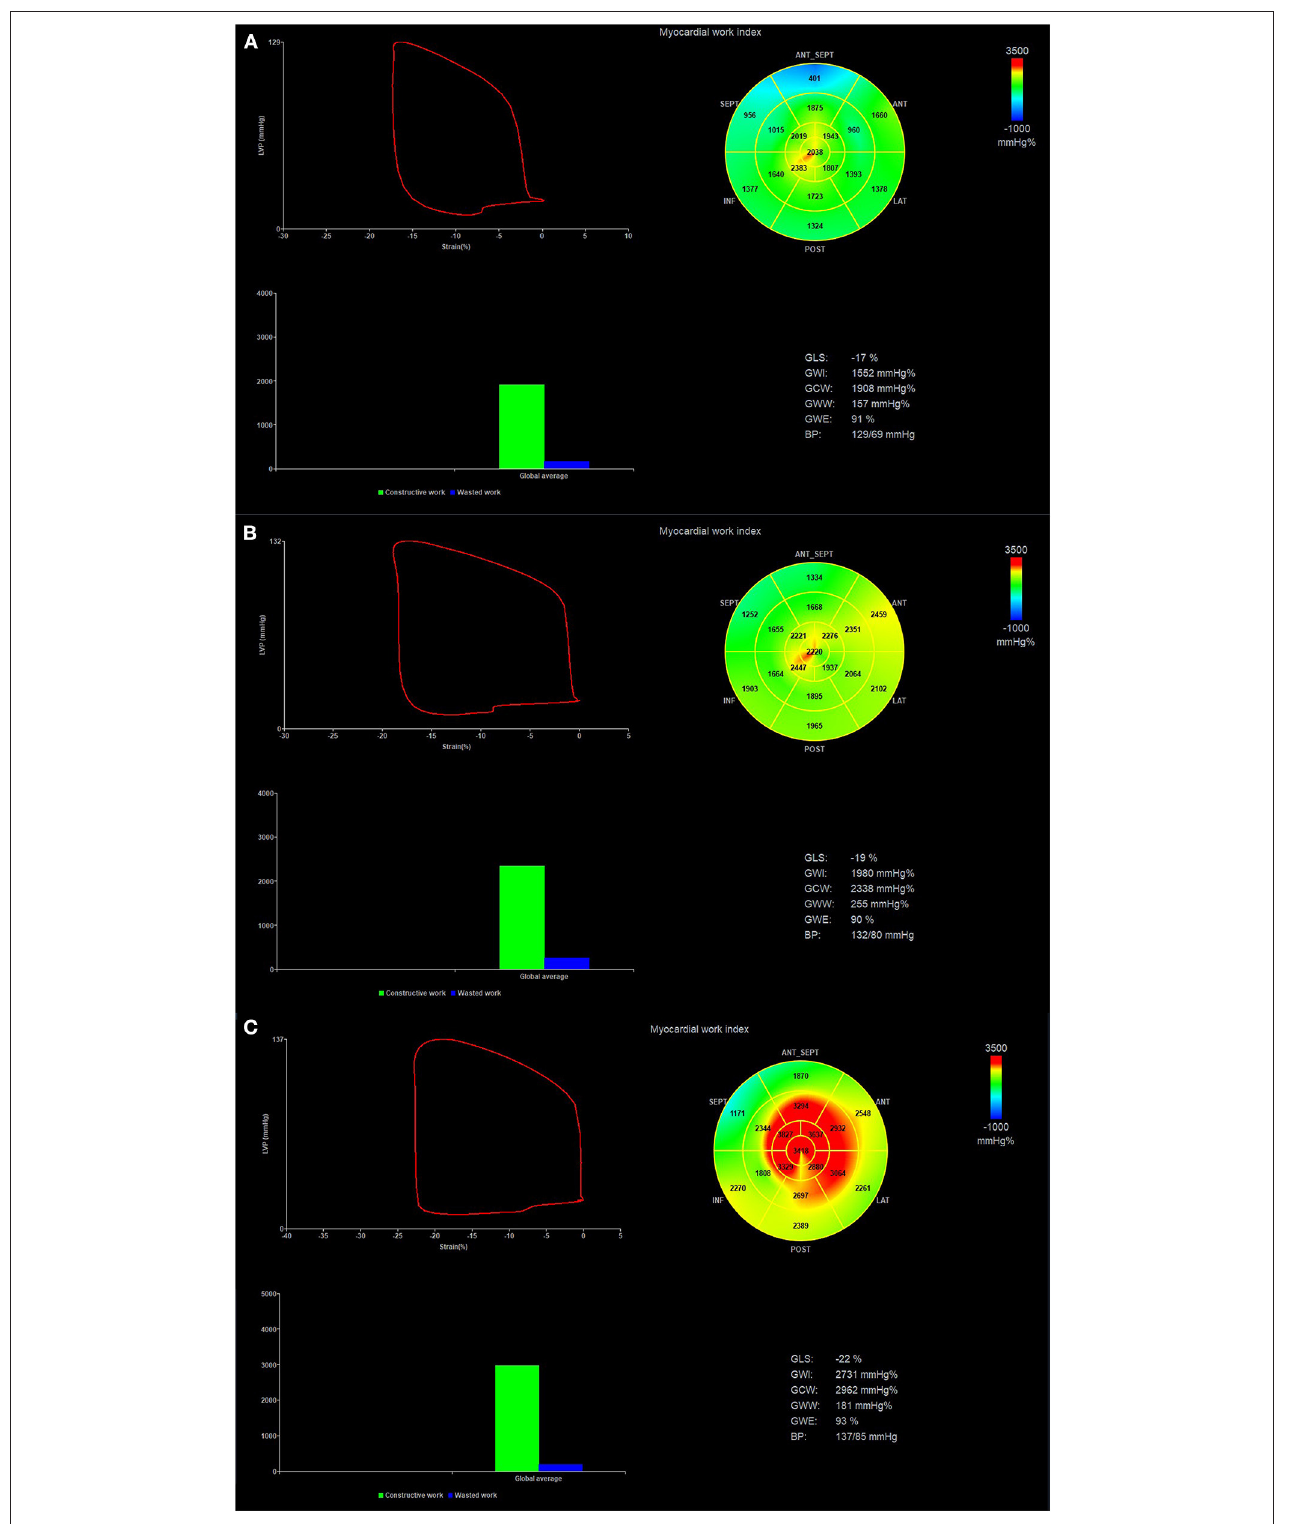
FIGURE 1 | Pressure-strain loop and values of myocardial work in patients with high-risk SCAD (A) , non-high-risk SCAD (B) and No CAD (C) . Regional myocardial work index in 17-segments at Bull’s eye diagram was represented. SCAD, stable coronary artery disease.